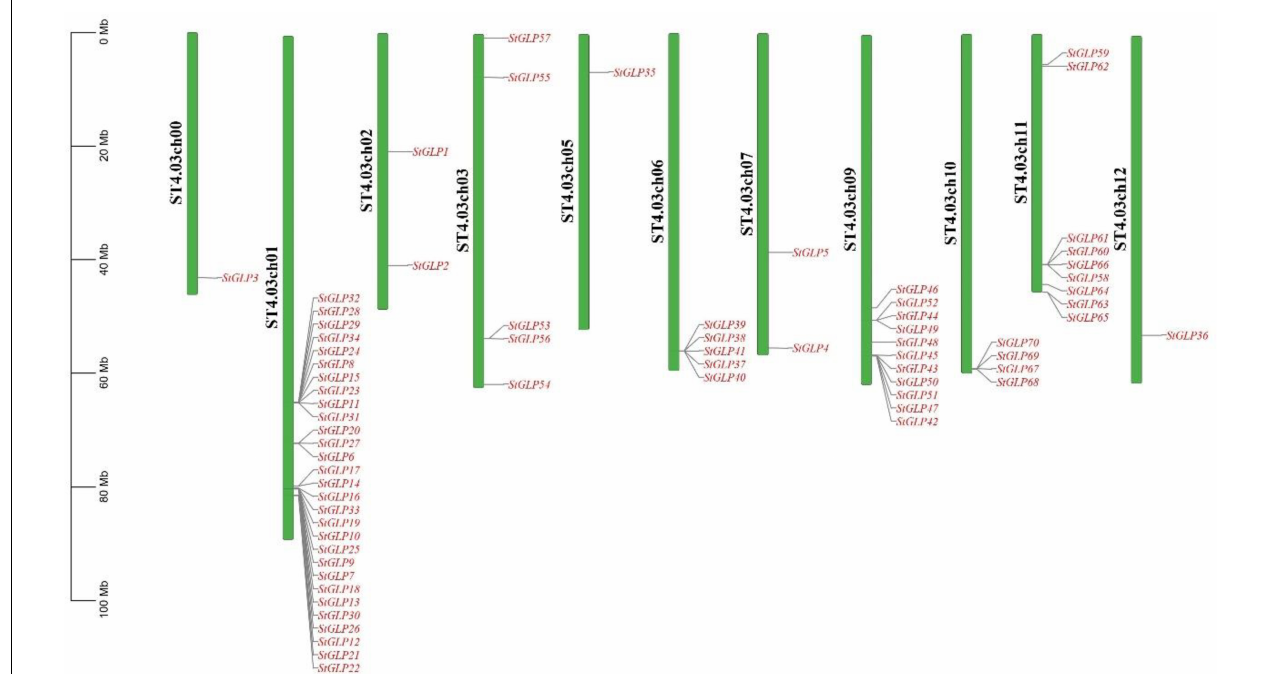
FIGURE 3 | Chromosomal distribution of StGLP genes. Green color shows chromosomes, red color shows StGLP genes, and black color shows the number of chromosomes.